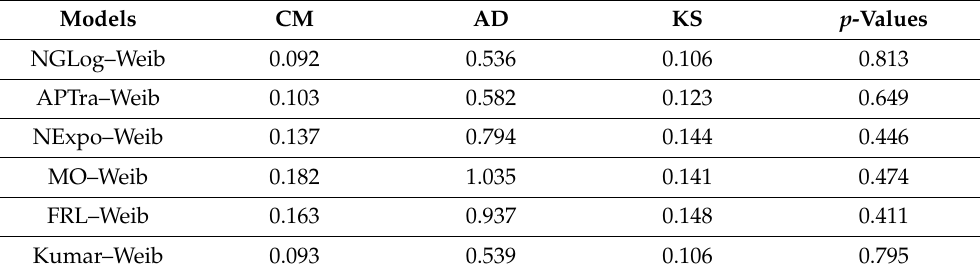
Table 13. The GFMs and p -values of the competing models for COVID-19 data (dataset 3). Models